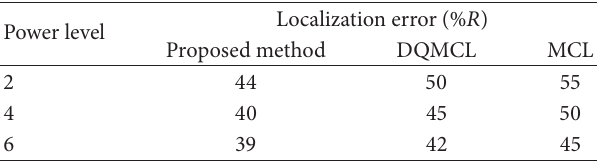
Table 5: Experimental measurement of localization error. Power level